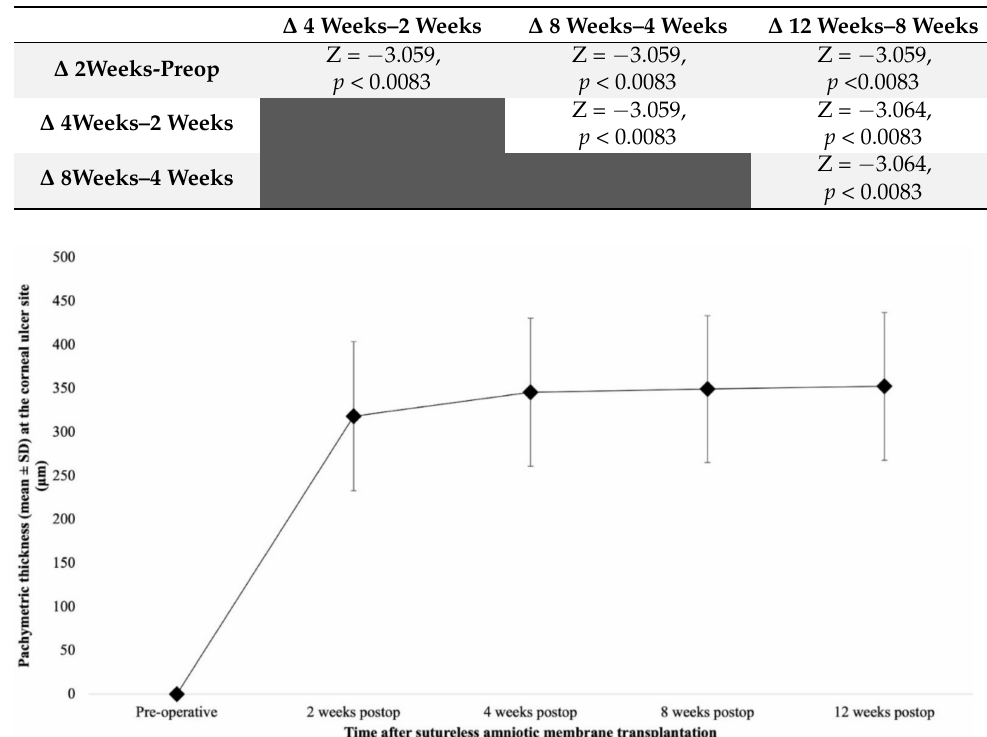
Table 2. Corneal pachymetric variation after treatment and during follow-up.